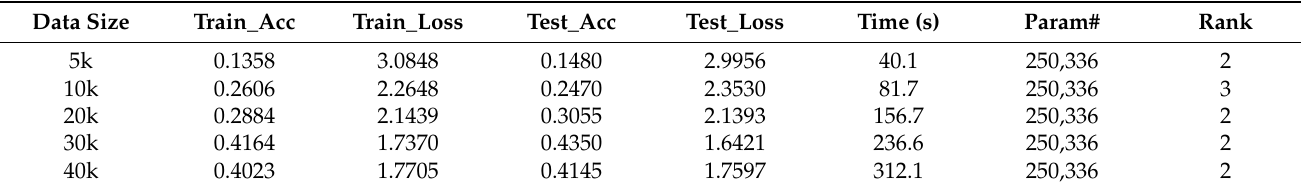
Table 4. Specific parameters and experimental results of the MLP model.